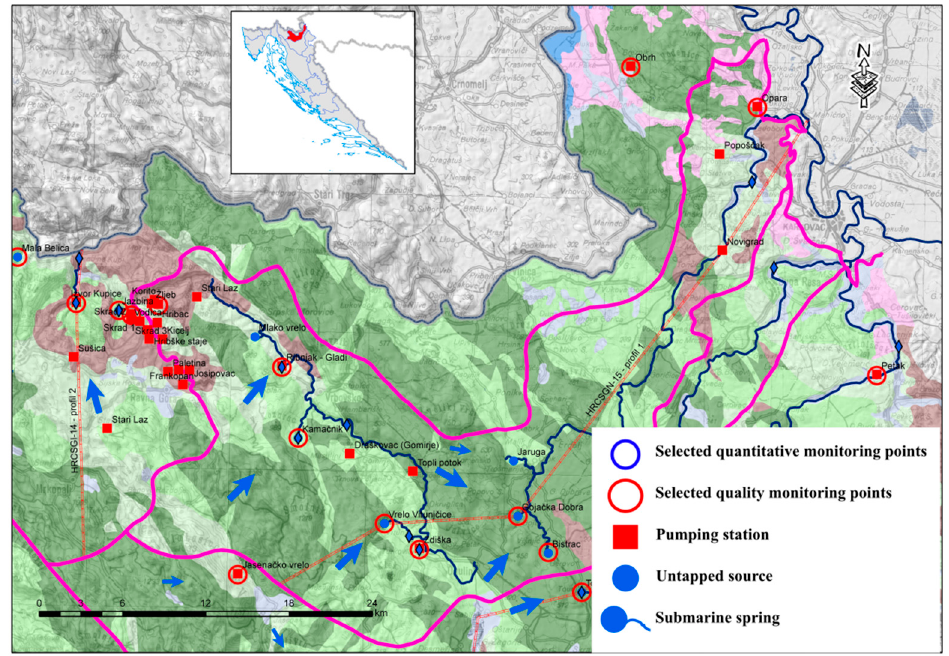
Figure 7. Spatial presentation of hydrological and hydrogeological relations in the Dobra River catchment [30].